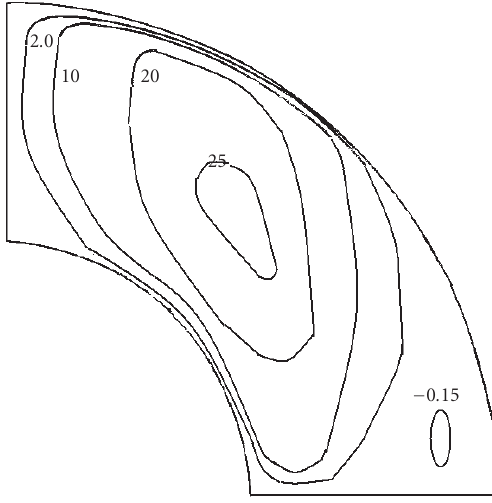
Figure 4.1. Level ψ curves multiplied by 10 4 for Re = 400.